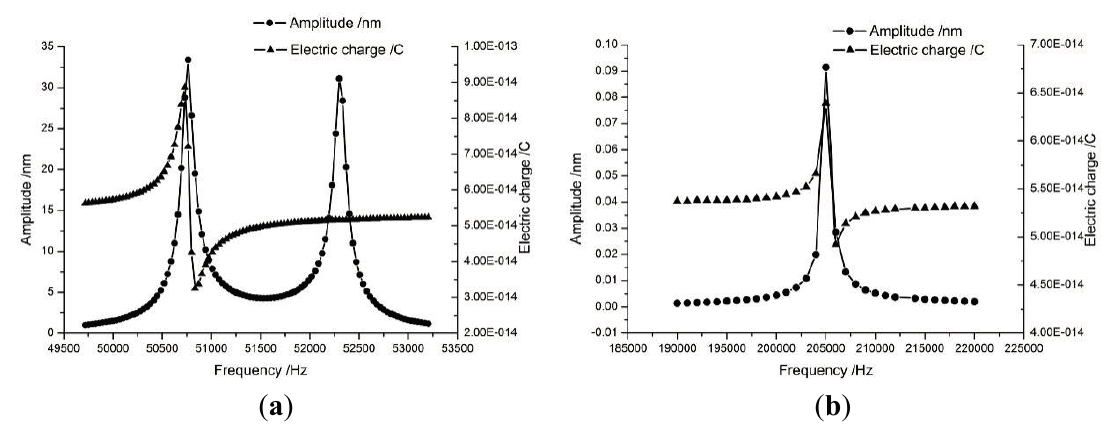
Figure 5. The frequency response curve predicted by FEA. ( a ) The first eigenmode; ( b ) The second eigenmode.